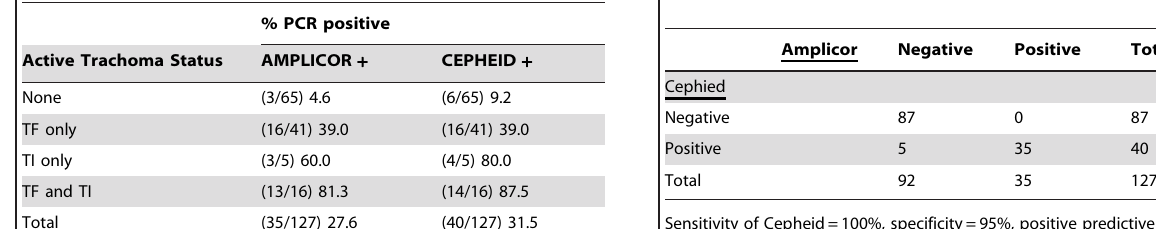
Table 3. Correspondence between Cepheid and